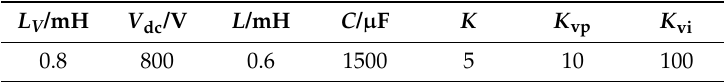
Table 2. Parameters of the droop